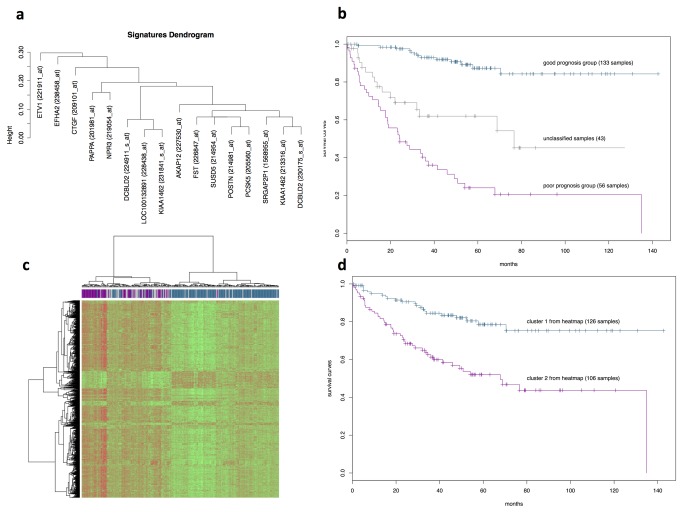
Analysis of the signatures generated by gSFA.
a. Dendrogram of the dichotomies generated by each of the 16 gSFA signatures (Table 1 and Figure S1); b. Survival plot of the 133 samples stably classified in the good prognosis group, 56 samples in the poor prognosis group and 43 uncertain samples (log-rank test gives p < 10--16); c. heatmap of DEGs between the two stable groups, Red indicates overexpressed genes (expression levels over the median) and green indicates underexpressed genes (expression levels under the median); d. survival curves samples in the two clusters of the heatmap as in c. (p = 6.6 ·10-6).